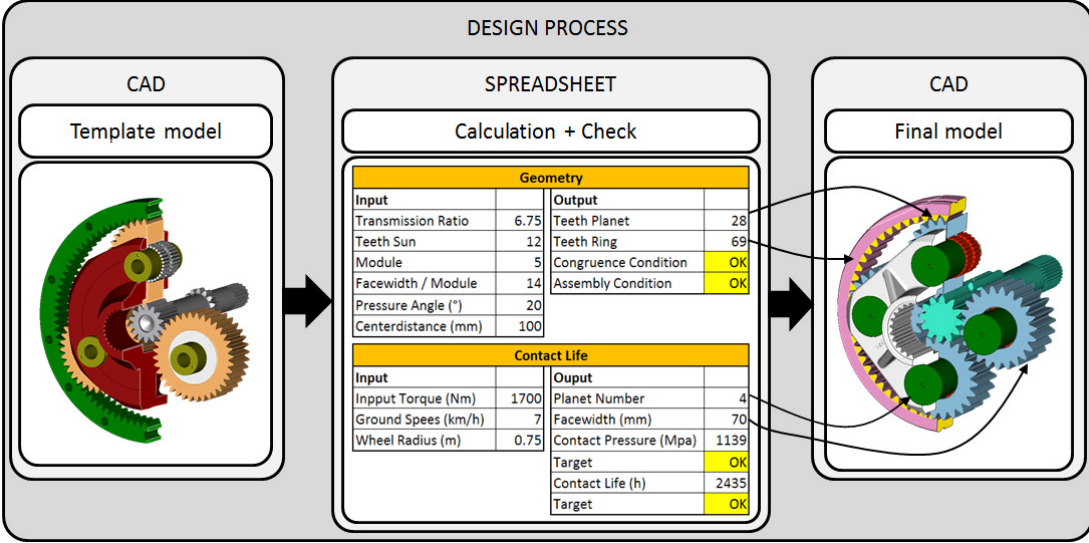
Figure 12. Design process (inputs, outputs) for the generation of the computer-aided design (CAD) model.